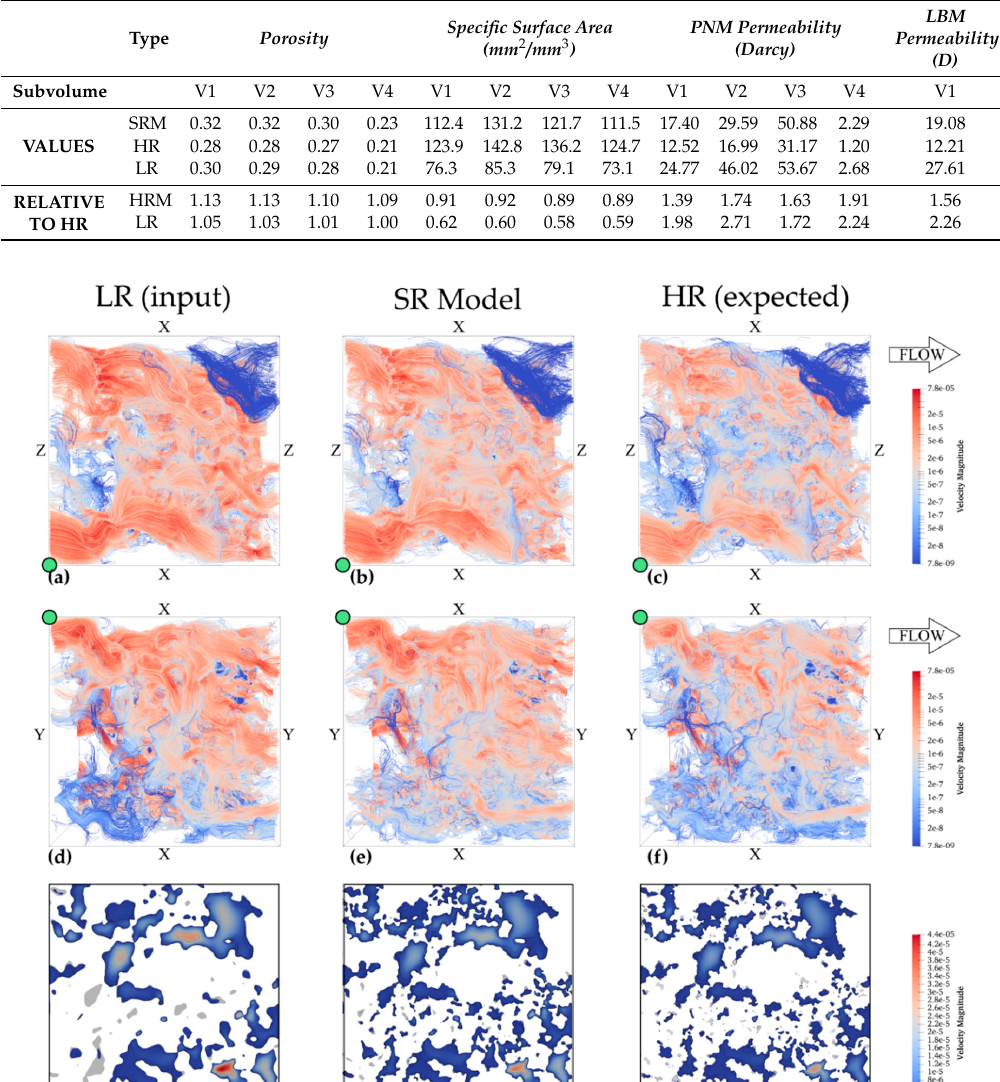
Table 5. Impact of super-resolution models on porosity, specific surface area and absolute permeability determined from pore network models (PNM) and from Lattice Boltzmann Method (LBM), studied for four volumes of 500 3 voxels each. Relative di ff erence with expected high-resolution data is added.